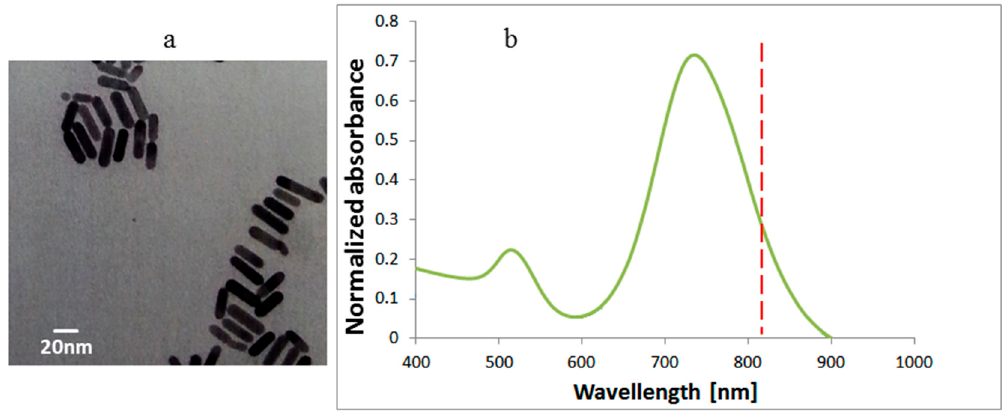
Figure 2. ( a ) Transmission Electron Microscope (TEM) image of the GNRs with 37 nm length and 10 nm diameter and ( b ) normalized the absorbance spectra of the GNRs. The laser wavelength is shown by a red dashed line.